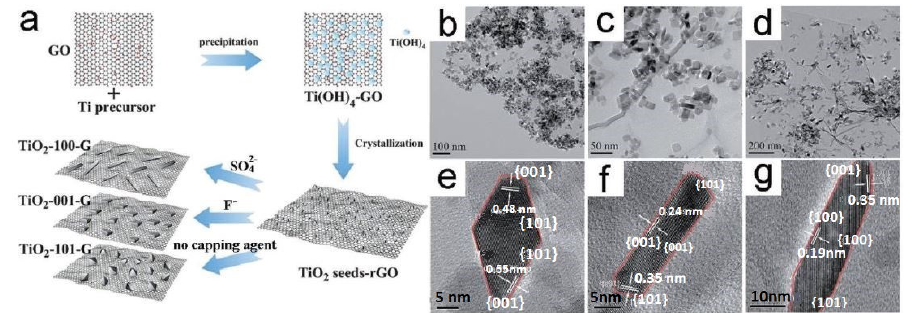
Figure 2 . ( a ) Schematic illustrating the synthesis of TiO 2 -graphene nanocomposites with controlla- ble TiO 2 crystal facets. ( b – g ) transmission electron microscopy (TEM) and high-resolution TEM (HRTEM) images of the as-prepared ( b , e ) TiO 2 -101-G, ( c , f ) TiO 2 -001-G, and ( d , g ) TiO 2 -100-G. (taken with permission from